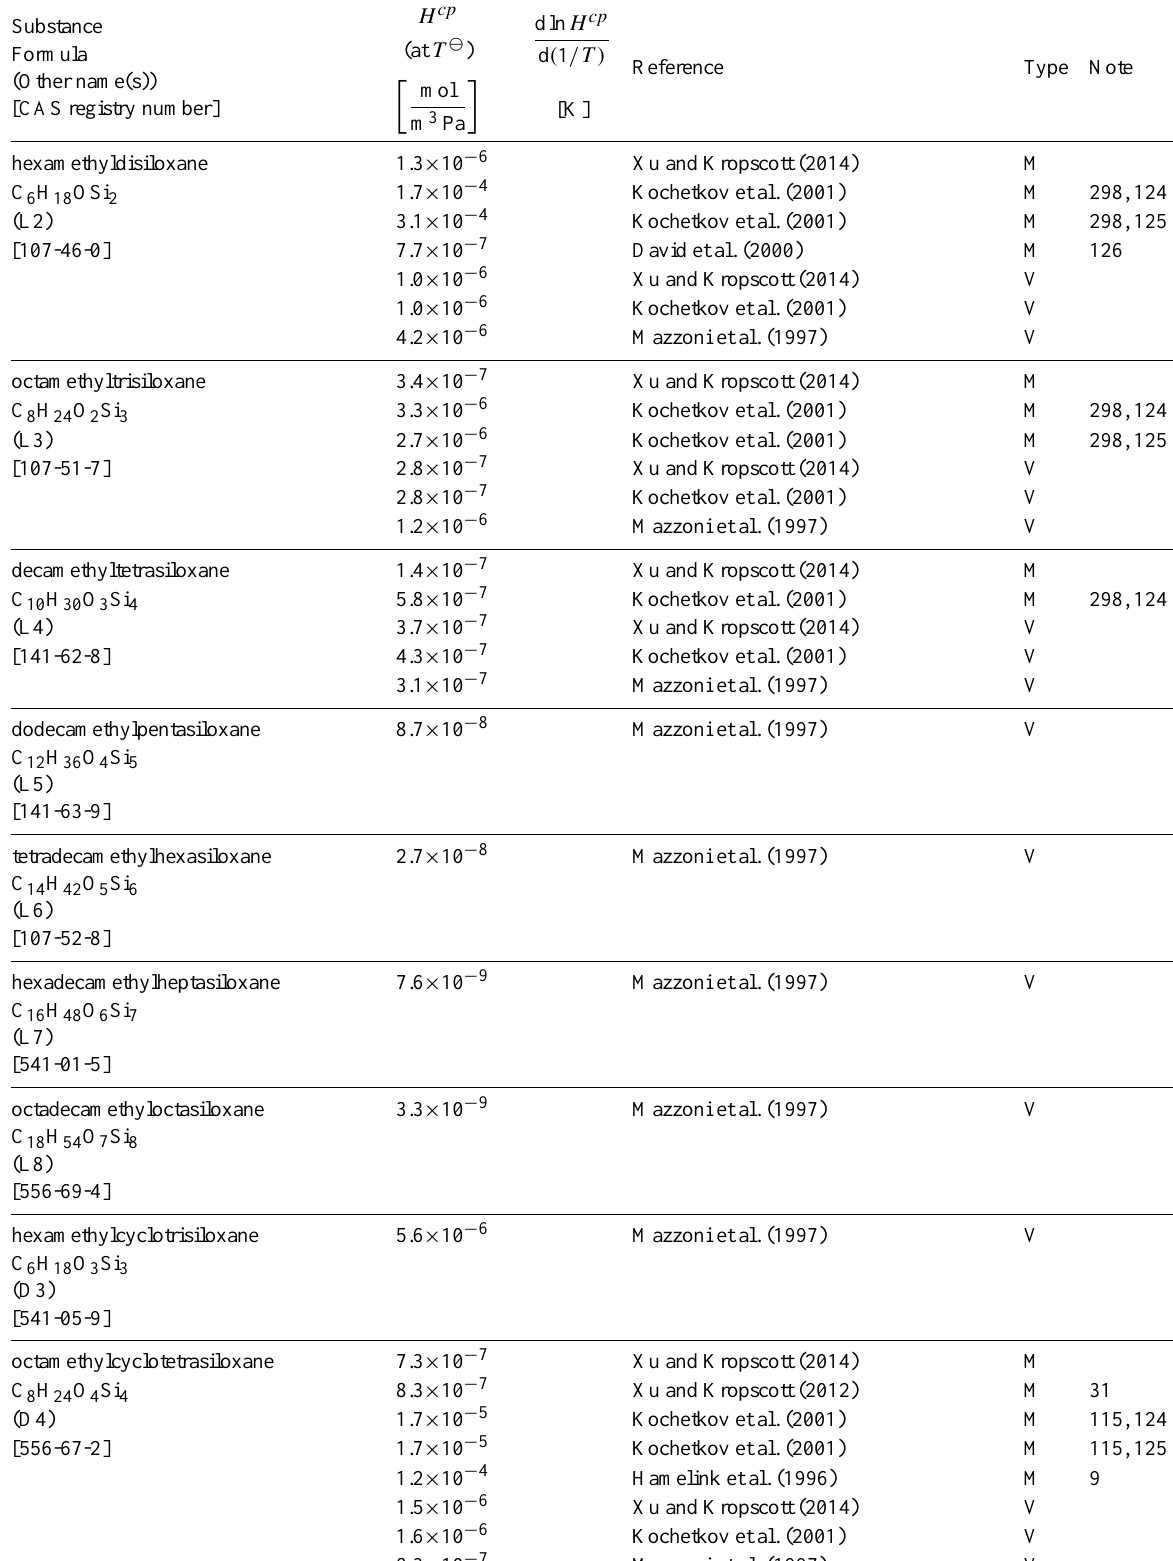
Table 6: Henry’s law constants for water as solvent